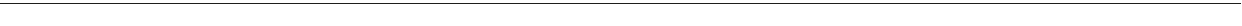
Fig. 5 Analysis of size-dependent control of RB-to-EB conversion using a stochastic mathematical model. a Proposed model in which the size of an RB determines whether it can convert or continues to replicate. RBs become progressively smaller because they divide, on average, at less than twice their starting size. They can only convert into an EB below a permissive size. These two elements of RB size control ensure that the RB population expands before conversion occurs. The fi gure demonstrates how weak control of RB size at replication can produce size heterogeneity and lead to asynchronous conversion by varying the number of replication cycles required to reach the conversion size threshold. b Wiring diagram to show the four different variables in the system and the four possible transformations. Details of the mathematical model provided in Supplementary Notes. c Mean volume of the RB population within an individual inclusion, measured experimentally (16 h.p.i. n = 8 RBs, 24 h.p.i. n = 40, 32 h.p.i. n = 245, 40 h.p.i. n = 240), or produced by the size control model, at selected time points. Error bars indicate standard deviation. d Histograms of RB size obtained with the mathematical model for